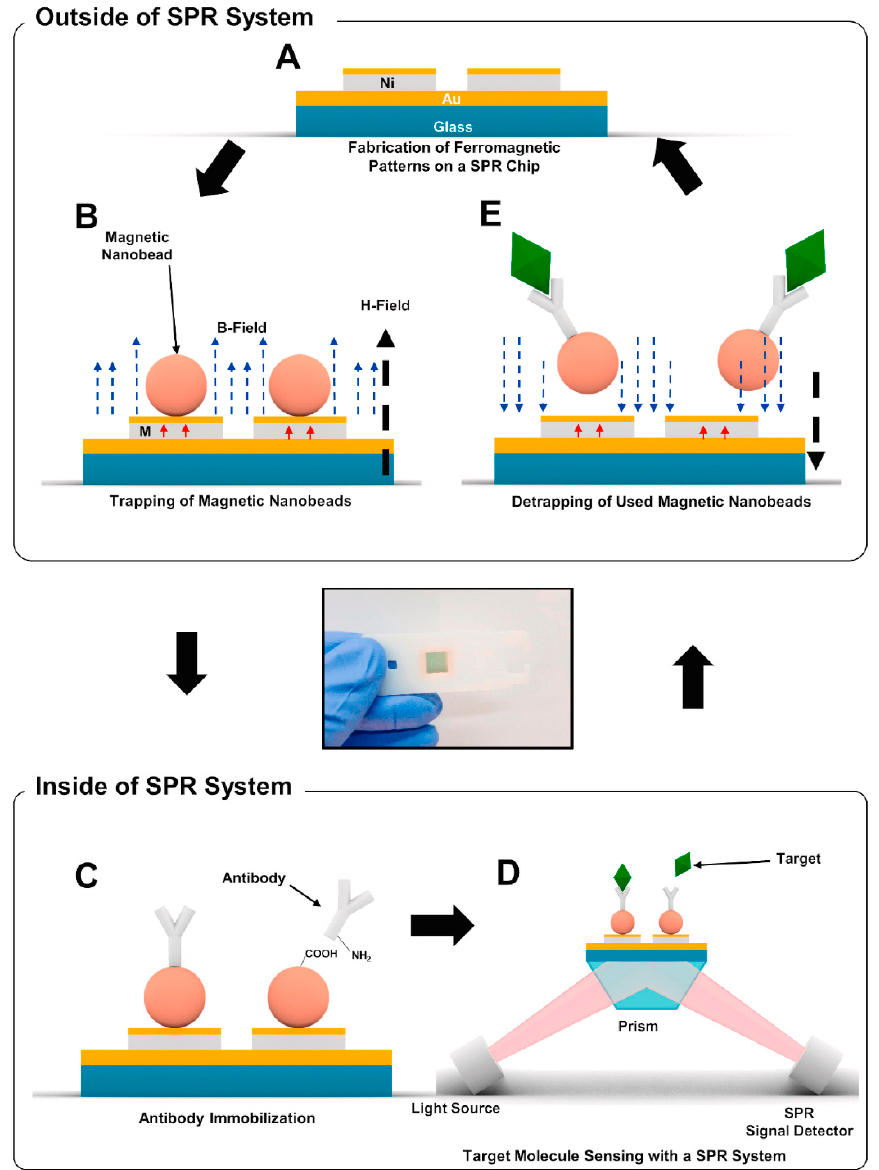
Figure 4. Schematic diagram depicting the cyclic process for the repeated sensing measurements using reusable SPR biosensor chip. ( A ) A reusable SPR chip including ferromagnetic nickel patterns on a conventional SPR chip structure. ( B ) Trapping of magnetic particles on the reusable SPR chip through an external magnetic field. ( C ) Immobilization of antibodies on magnetic particles using EDC-NHS coupling in a conventional SPR system. ( D ) Detection of target molecules. ( E ) Removal of magnetic particles by an external magnetic field in an opposite direction to that for trapping. Reprinted permission obtained from [70] .